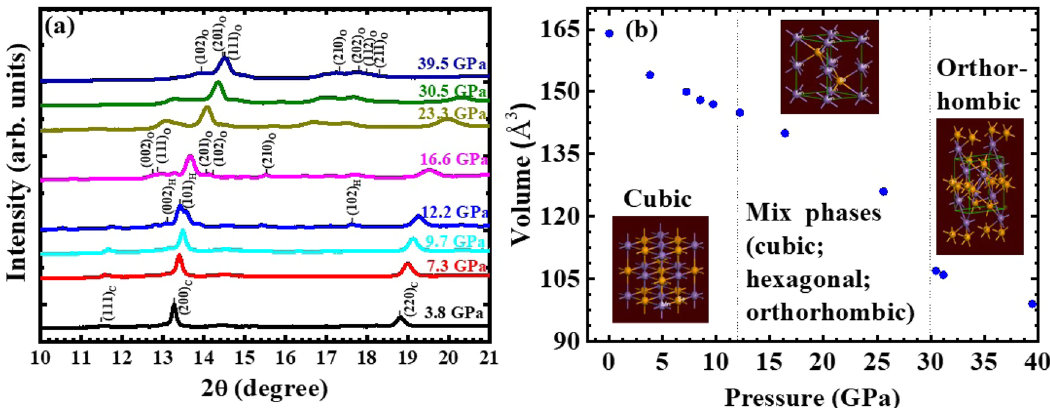
Fig. 4 The XRD at pressures in MnSe. a In situ synchrotron XRD patterns of MnSe during compression at room temperature; b the pressure dependence of volume for MnSe. The initial structure is cubic phase, and the intermediate structure retains cubic phase and exhibits the new hexagonal and orthorhombic phases, and the fi nal structure is orthorhombic phase, which could be a new